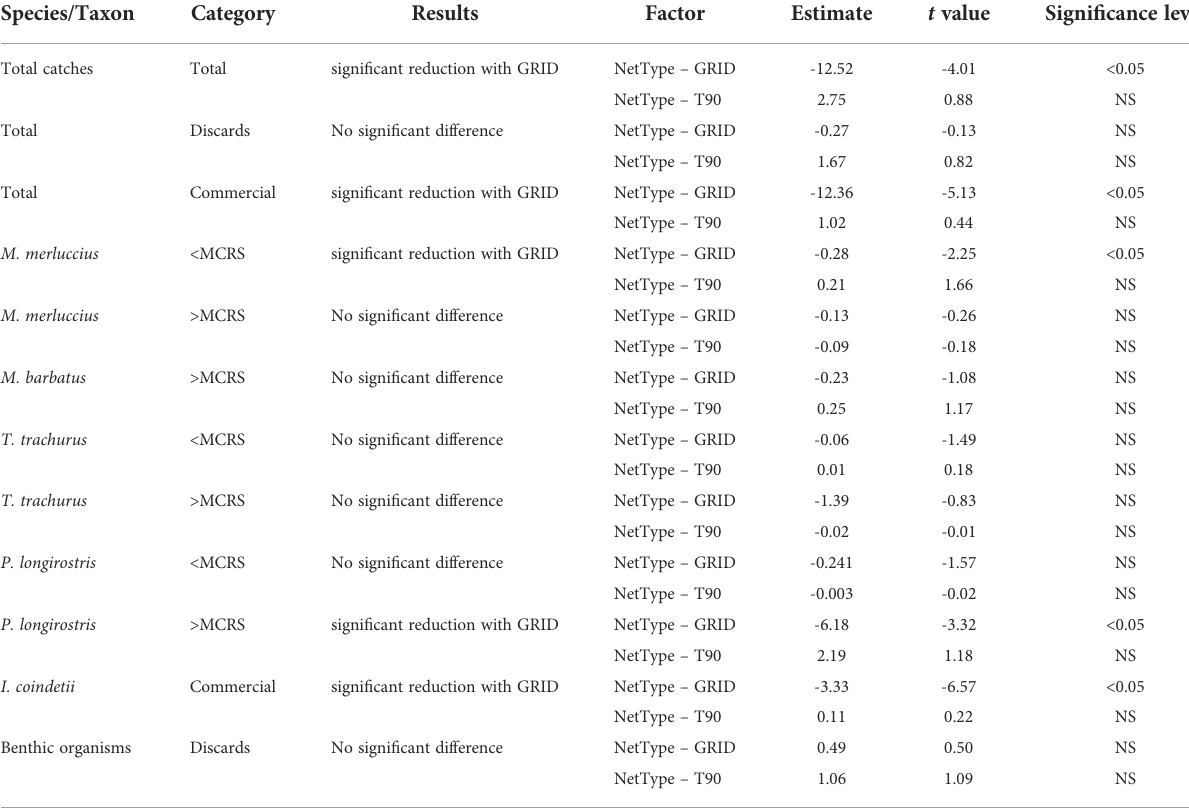
TABLE 2 Summary of the results of the GAM analyses performed on the catch rates (kg h -1 ) of a suite of 12 combinations of species/taxa and categories.